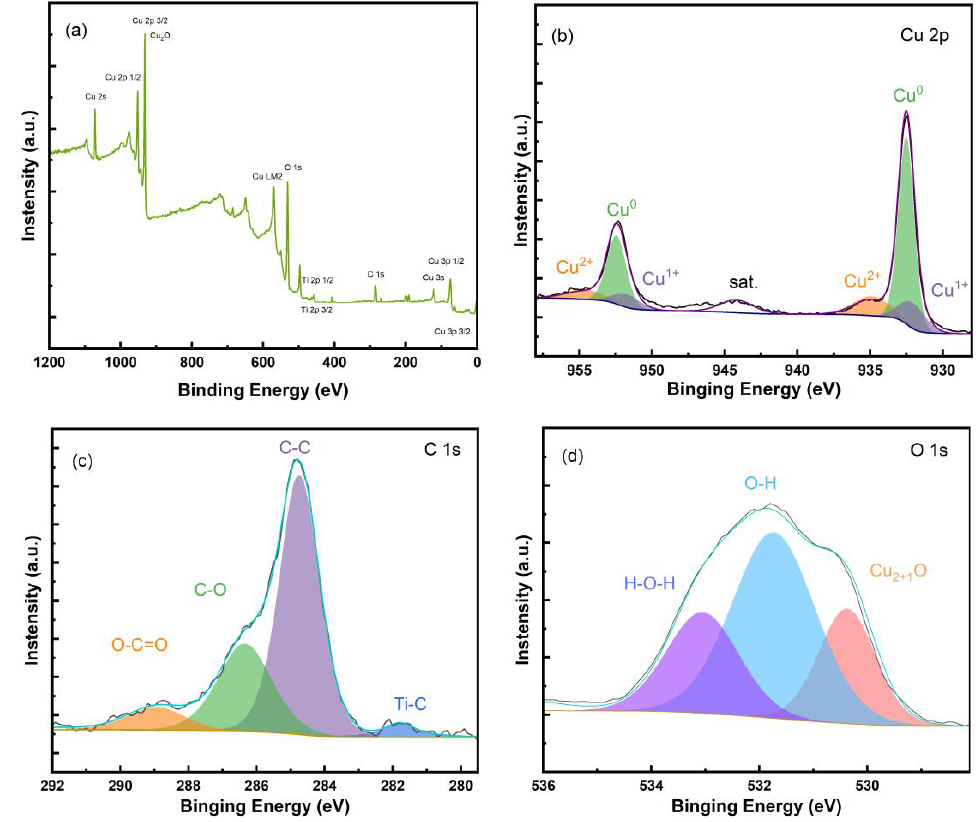
Figure 6. XPS spectra of Cu/Ti 3 C 2 T x : ( a ) full spectrum of Cu/Ti 3 C 2 T x , ( b ) Cu 2p spectra of Cu/Ti 3 C 2 T x , ( c ) C 1s spectra of Cu/Ti 3 C 2 T x , ( d ) O 1s spectra of Cu/Ti 3 C 2 T x .